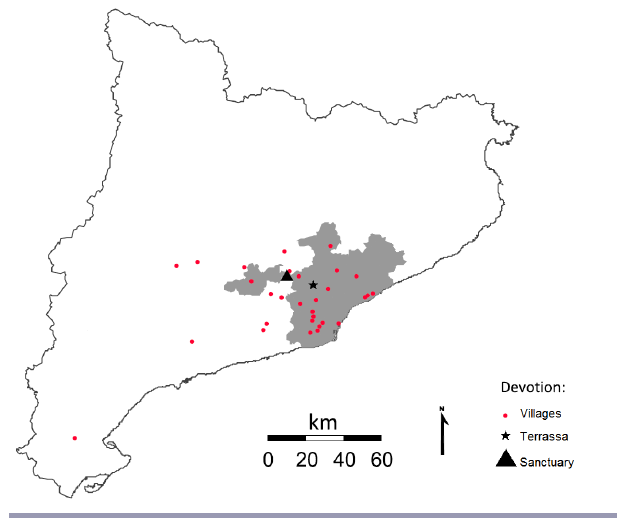
Fig. 4 . Periodicity (a) and seasonality (b) of extraordinary pilgrimages. Note: periodicity was calculated as the time interval between two consecutive pilgrimages. Seasonality was based on astronomical seasons in Spain: spring (20th March